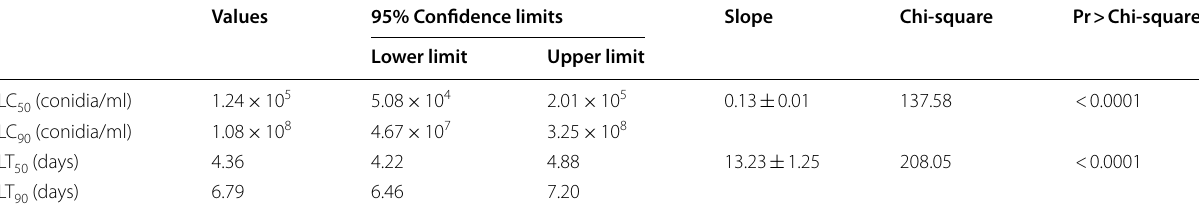
10 7 conidia/ml against Bemisia tabaci nymphs after ×